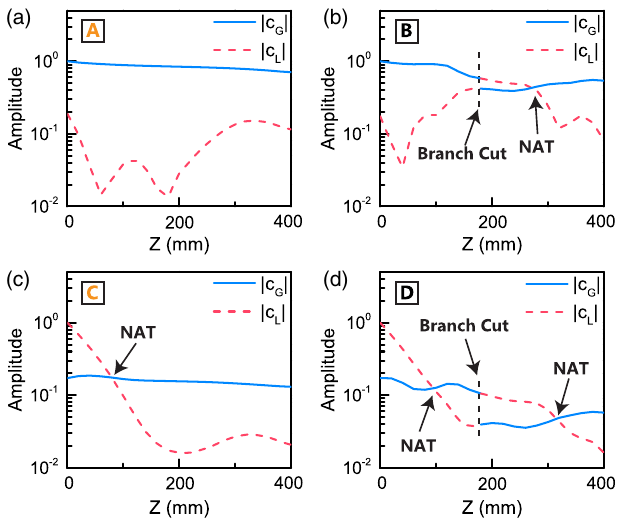
FIG. 9. (a) – (d) Calculated amplitudes of the eigenstates along the waveguiding direction for configurations A –